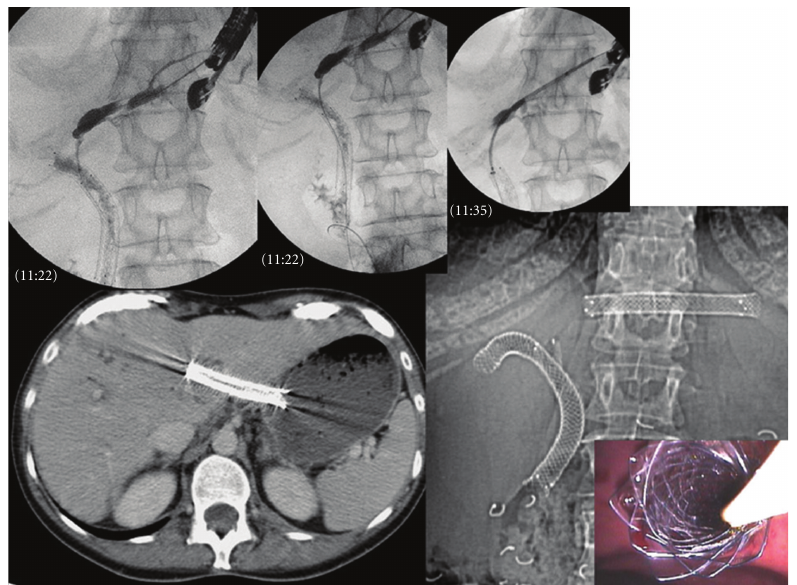
Figure 3: Hepaticogastrostomy performed after ERCP failed to drain the left hepatic lobe in patient with a Klatskin Tumor. Table 1: Summary of the published literature on EUS-HG and related transmural intrahepatic